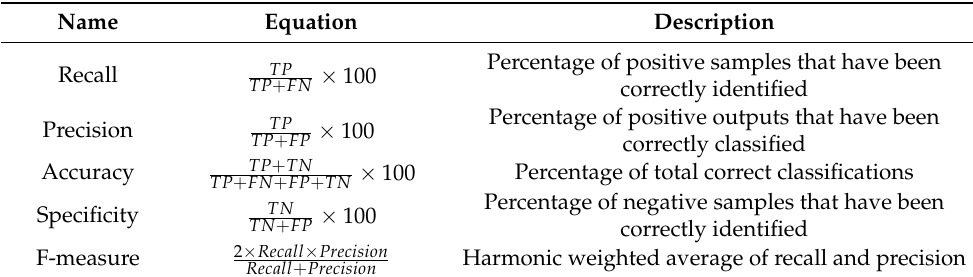
Table 3. Performance parameters of a classifier associated with the confusion matrix. TP: true positives; TN: true negatives; FN: false negatives; FP: false